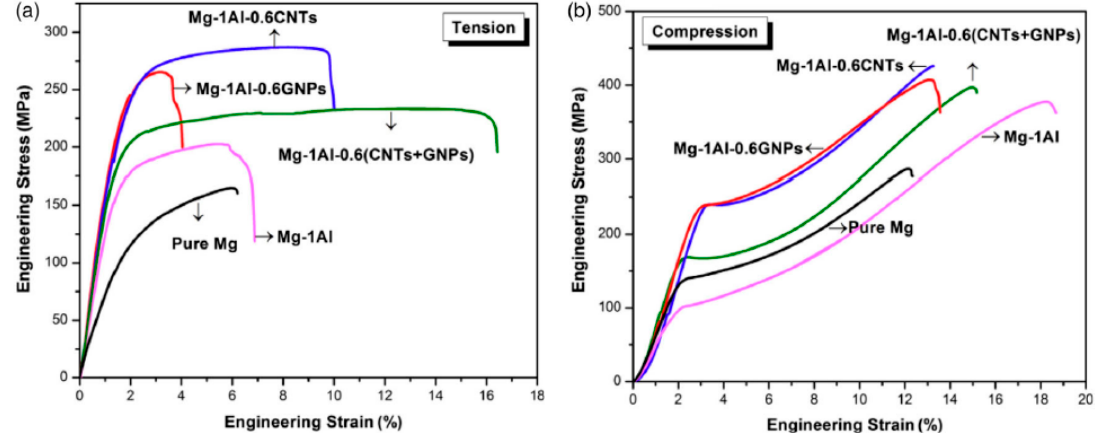
Figure 13. ( a ) Tensile and ( b ) compression stress–strain curves for pure magnesium and its nanocomposites at room temperature [63] (Copyright Elsevier, 2014, Journal of Alloys and Compounds).